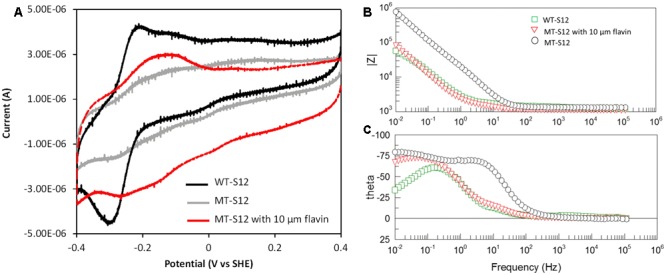
(A) CV of biofilms in different anodic cultures. Scan rate = 0.01 V/s, pH = 0.68. (B) Bode-diagram of EIS analysis. (C) Phase angle (theta)-frequency plots of EIS analysis, with an AC voltage amplitude of 10 mV and a frequency range from 100 mHz to 100 KHz.